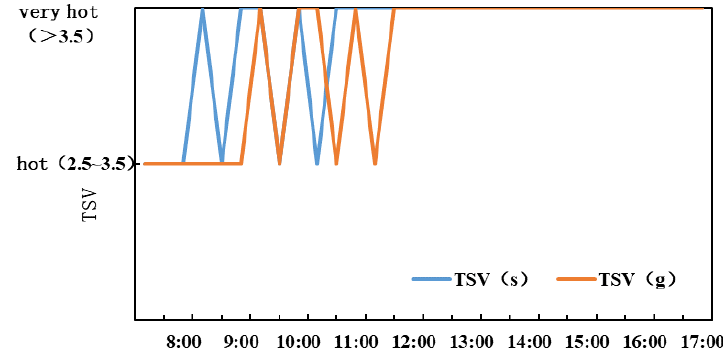
Figure 12. TSV calculation results of representative day in summer.